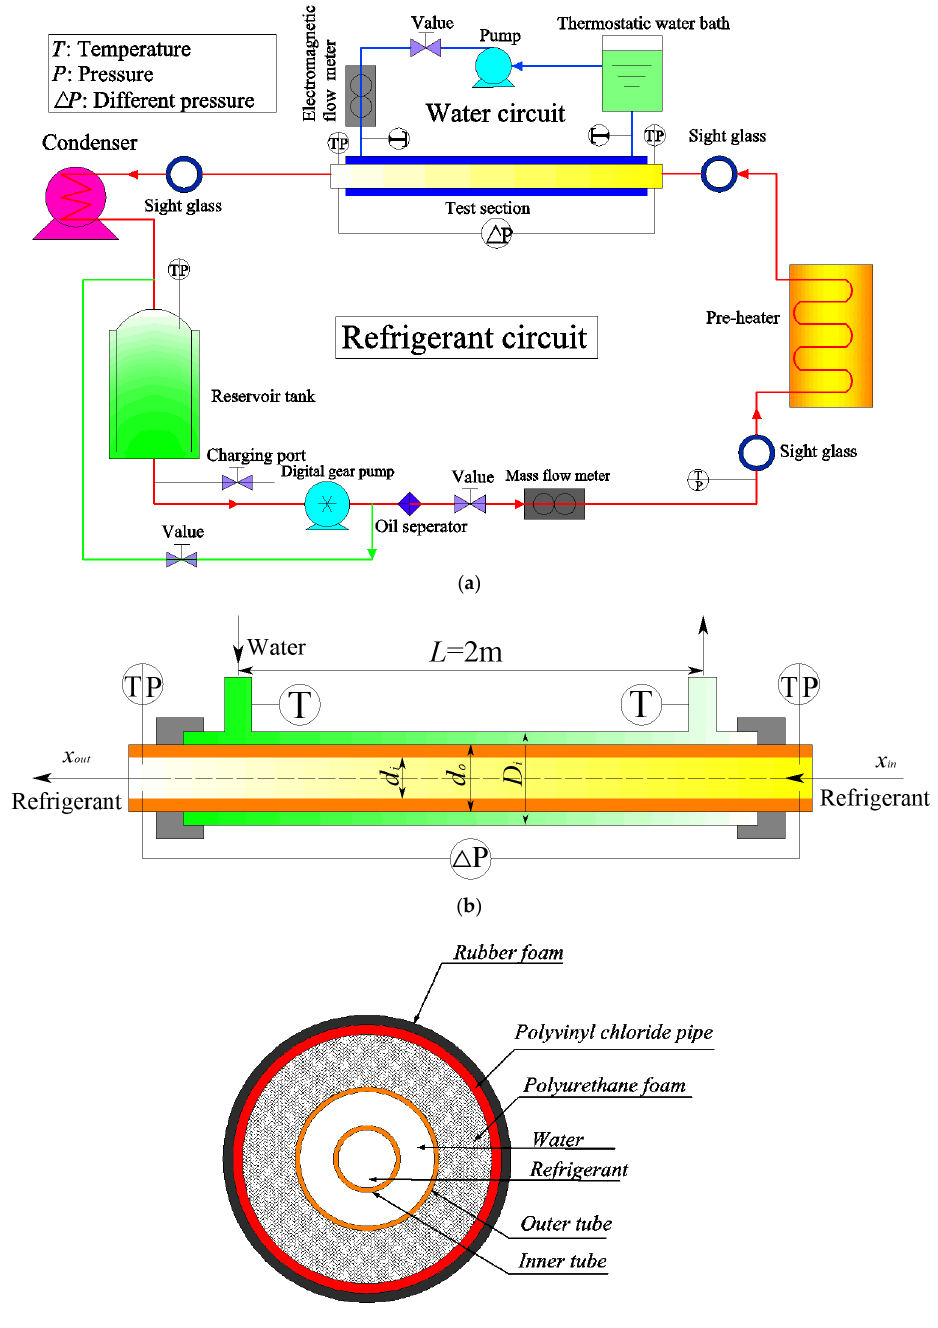
Figure 2. Schematic diagram of the ( a ) experimental system, ( b ) test section, ( c ) cross-section of the test